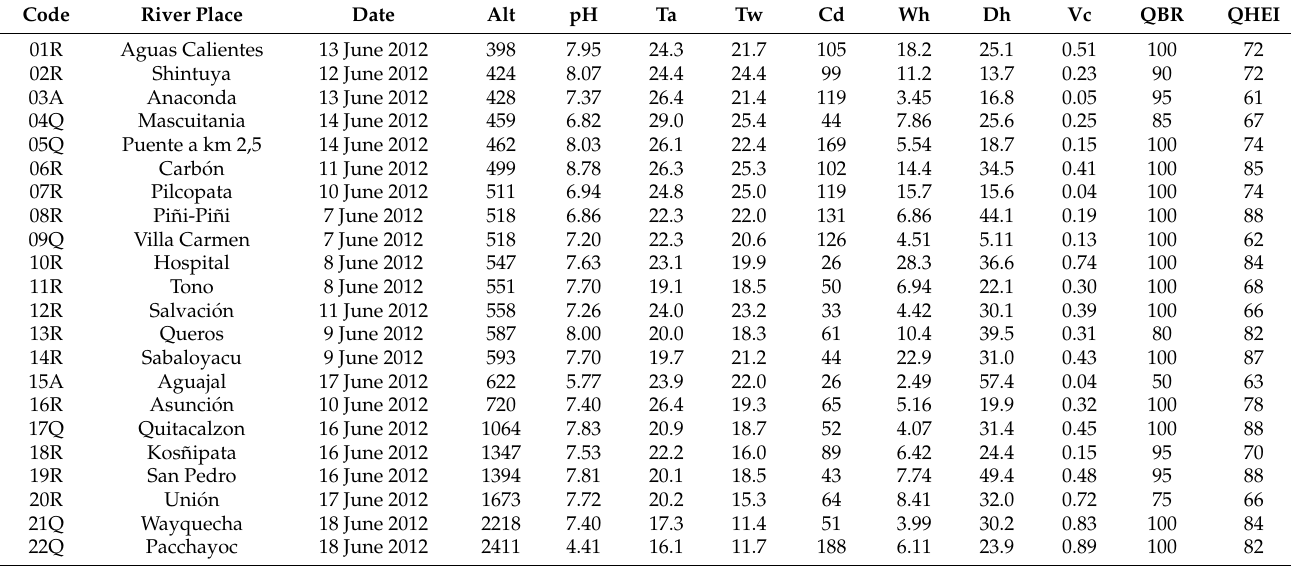
Table 1. Sampling sites and environmental variables in Alto Madre de Dios River,